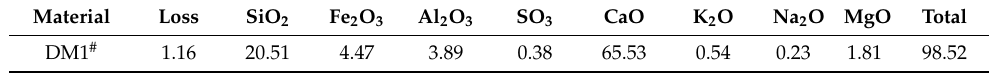
Table 1. The chemical composition of cement clinker (wt/%).